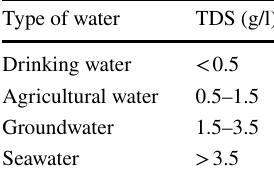
Table 1 The classifications of water by total dissolved solids (DeZuane 1997)